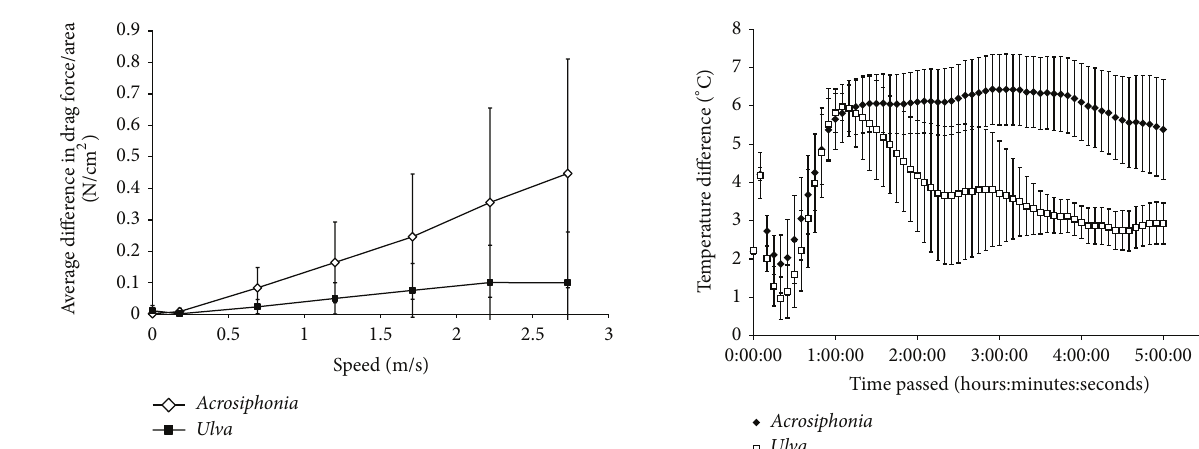
Figure 5: Average temperature difference (mean ± standard devi- ation) between limpets before and after having epibionts removed. Ulva and Acrosiphonia appear to have a similar cooling effect until after one hour had